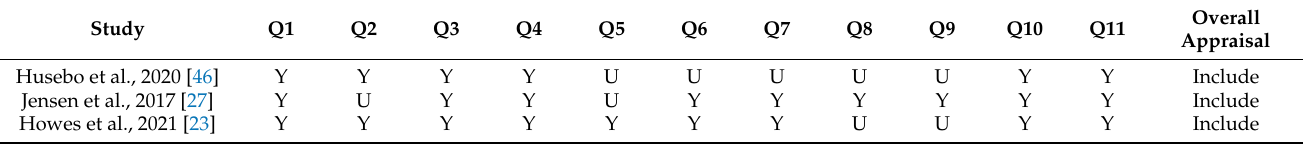
Table A7. The methodological quality assessment results of systematic